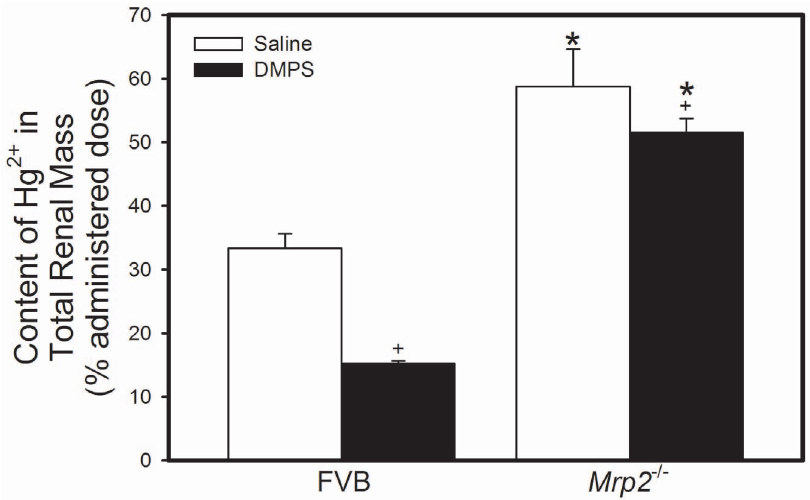
Figure 1. Content of Mercury in the Total Renal Mass of Mrp2 2 / 2 and FVB Mice. Mrp2 2 / 2 and FVB mice were injected intraperitoneally with a dose of 0.5 m mol ? kg 2 1 ? 8 mL 2 1 HgCl 2 . Kidneys were harvested 48 h after injection with HgCl 2 . Data represent mean 6 SE of kidneys from four mice. *, significantly different from mean of corresponding FVB mice (p , 0.05). + , significantly different from mean of mice from same strain treated with saline (p ,